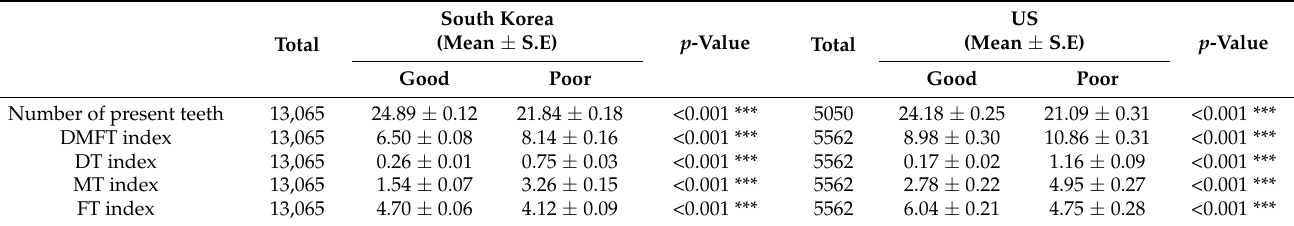
Table 2. Differences in SROH according to oral health